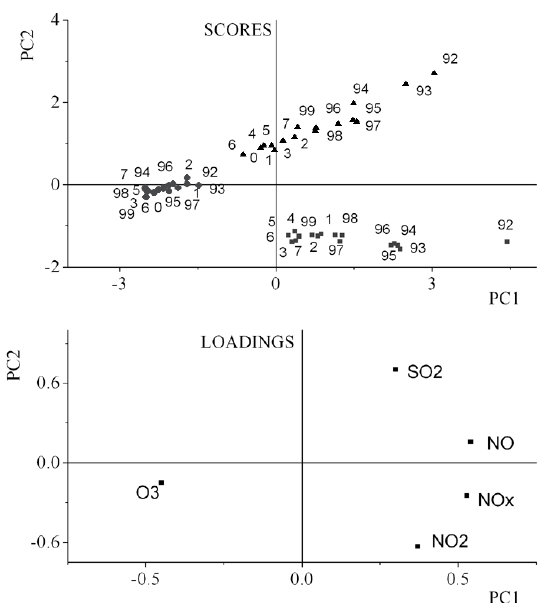
Figure 4. Score plot and loading plot for the Principal Component Analysis (PCA) model performed on the (16 yearly averages × 3 sites) × 5 variables data matrix (62% PC1, 28% PC2). Samples are labeled according to the sampling site: triangle = Lecco; square = Como; circle = Varenna.